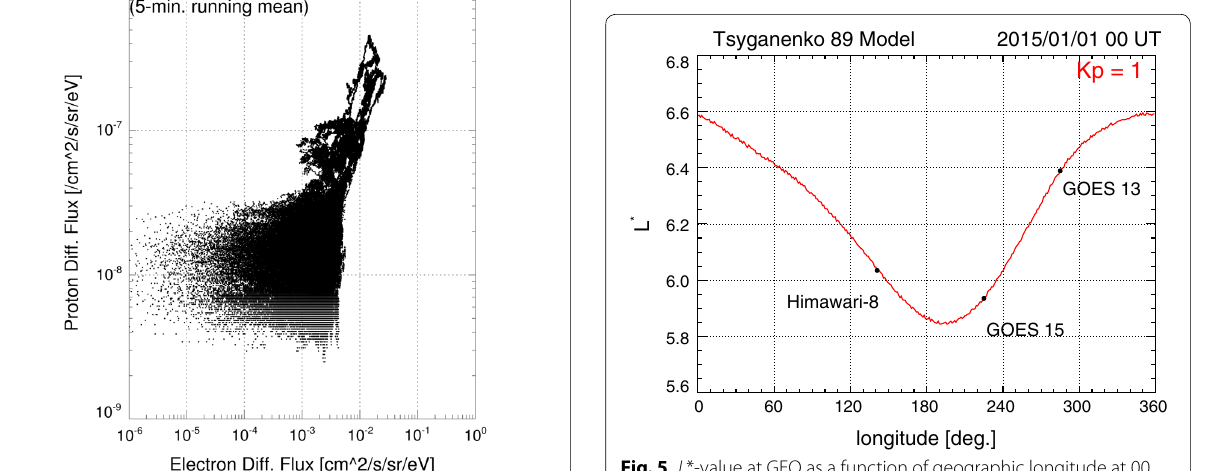
Fig. 5 L *-value at GEO as a function of geographic longitude at 00 UT on January 01, 2015 for Kp 1. The L *-values of Himawari-8, GOES = 13, and GOES 15 are plotted as solid black